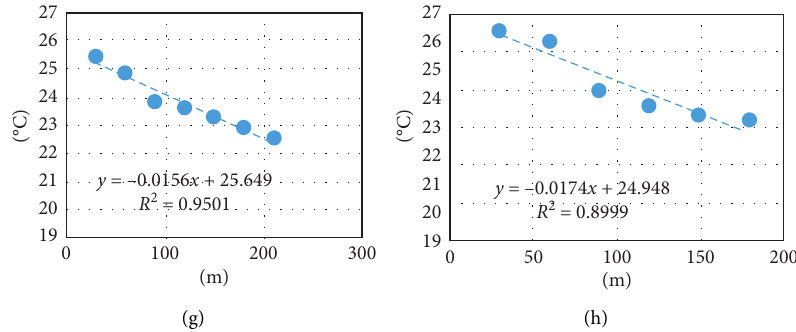
Figure 13: LST linear regression model of eight intersections’ area.